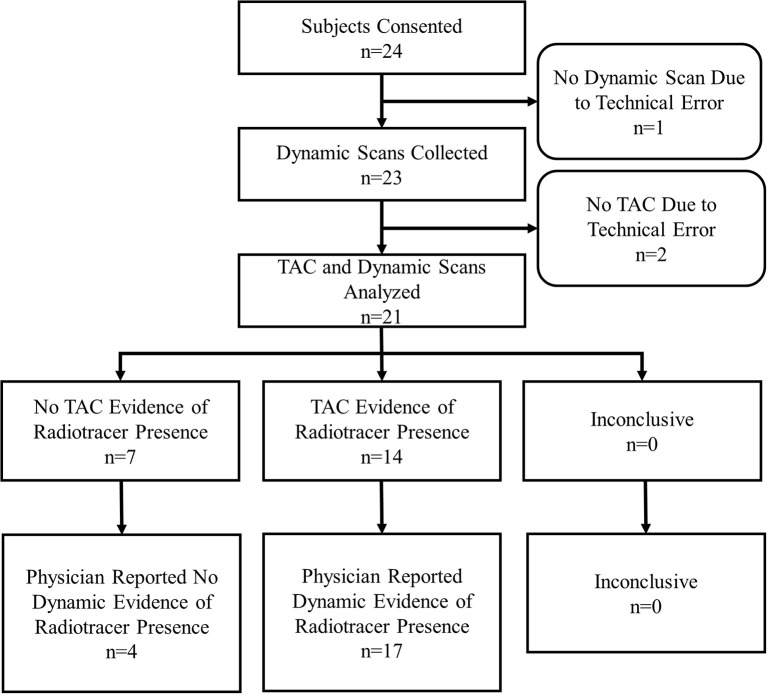
Subject flow chart.